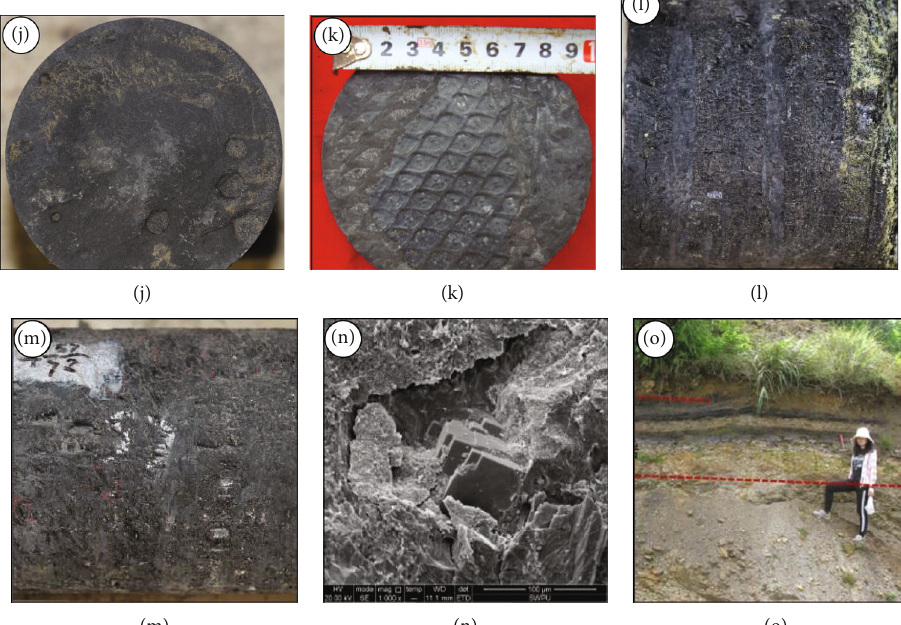
Figure 2: Photographs of the lithology of the Lopingian coal-bearing system in the southern Sichuan area: (a) gray conglomerate, meandering river channel retention sediment, Xunsi section, Junlian; (b) conglomerate-bearing fi ne sandstone, fl attened mud gravel with biaxially aligned tectonics, matrix-supported, average rounded, and poorly sorted, borehole YSL1, 610.5m in depth, lower member of the Longtan Formation; (c) conglomerate-bearing fi ne sandstone, fl attened mud gravel with biaxially aligned tectonics, matrix-supported, poorly rounded, and poorly sorted, storm event disturbance structure, borehole YSL1, 582.5 m in depth, upper member of Longtan Formation; (d) lenticular bedding sandstone, borehole Z105, 581.56 m in depth, Junlian; (e) lenticular bedding sandstone with well- developed bioturbation structure, borehole YSL152, 581.5m in depth; (f) tidal bedding-trough-shaped cross-bedded sandstone with well- developed bioturbation structure, borehole YSL152, 582.5 m in depth, Junlian; (g) rhodolitic mudstone with oolitic tectonics, borehole YSL152, 607.5 m in depth, upper member of Longtan Formation; (h) muddy limestone, Xuyong; (i) dark mudstone with marine faunal fossils, borehole YSL1, 610.5m in depth, upper member of Longtan Formation; (j) dark mudstone with biogenic subduction development, borehole YSL152, 581.7m in depth, upper member of the Longtan Formation; (k) dark mudstone with Lepidodendron fossils, borehole Z105, 609.3m in depth, upper member of the Longtan Formation; (l) primary-fractured structural coal with pyrite layer- fi lled fi ssures, borehole YSL37, Muai, Junlian; (m) primary-fractured structural coal, borehole YSL37, Muai, Junlian; (n) calcite cement in coal, borehole YSL1, 608.7m in depth, Muai, Junlian; (o) Bauxitic mudstone, developing pyrite crystals, bottom of Longtan Formation. 10cm diameter core in borehole YSL1, 5 cm diameter in other cores, geological hammer length about 30